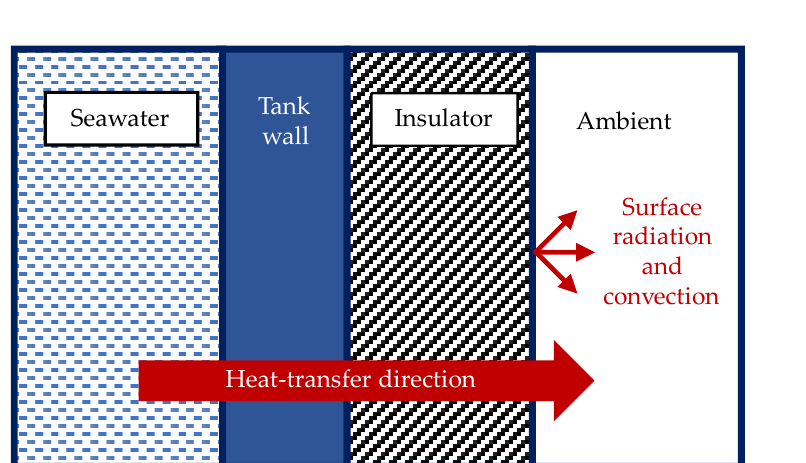
For the IGCC power plant biohydrogen production system, the low steam pressure from the IGCC power-generation process was the waste heat source from the IGCC power plant that was recovered through a shell and tube heat exchanger. The fluid inside the feed-mixing tank was heated with the recovered heat. The temperature outlet of the heat exchanger was set at 90 ◦ C. Figure 8 illustrates the simplified structures of the feed-mixing and bioreactor tanks as well as their heat interaction. As is shown in the figure, both of the tanks were cylindrical structures equipped with an external coil heater and insulator. Nevertheless, the bioreactor tank had an additional vertical bundle heater inside the reactor. The purpose of adding the heaters was to heat and maintain the fluid temperature inside the tanks at optimal conditions in large